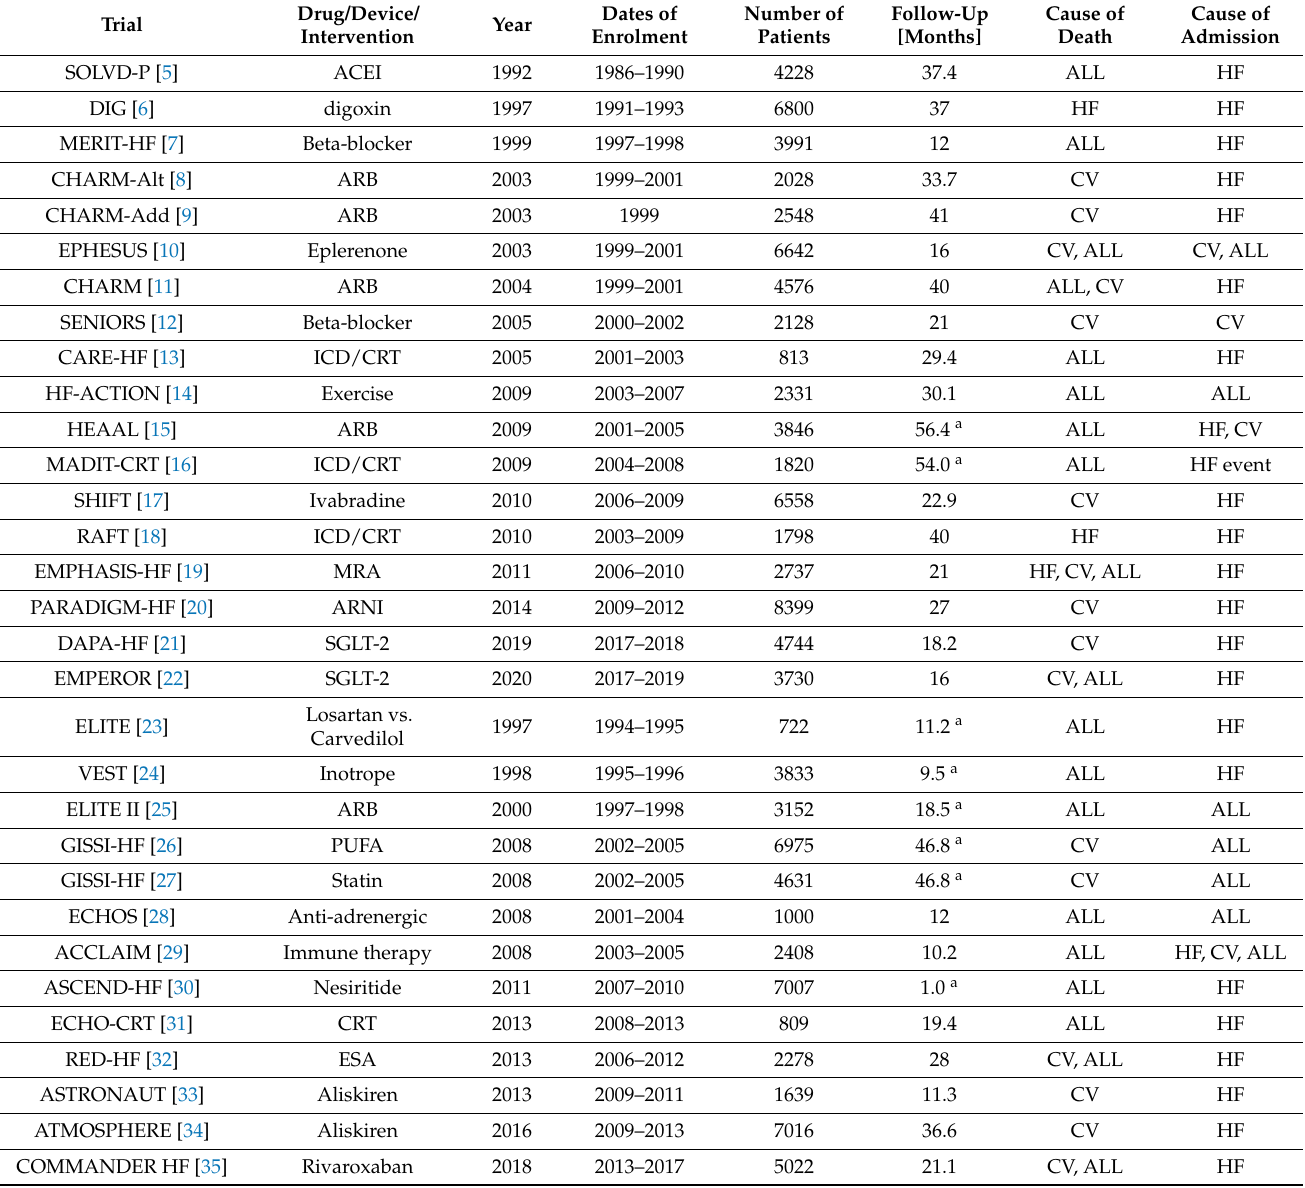
Table 1. The characteristics of trials included in the